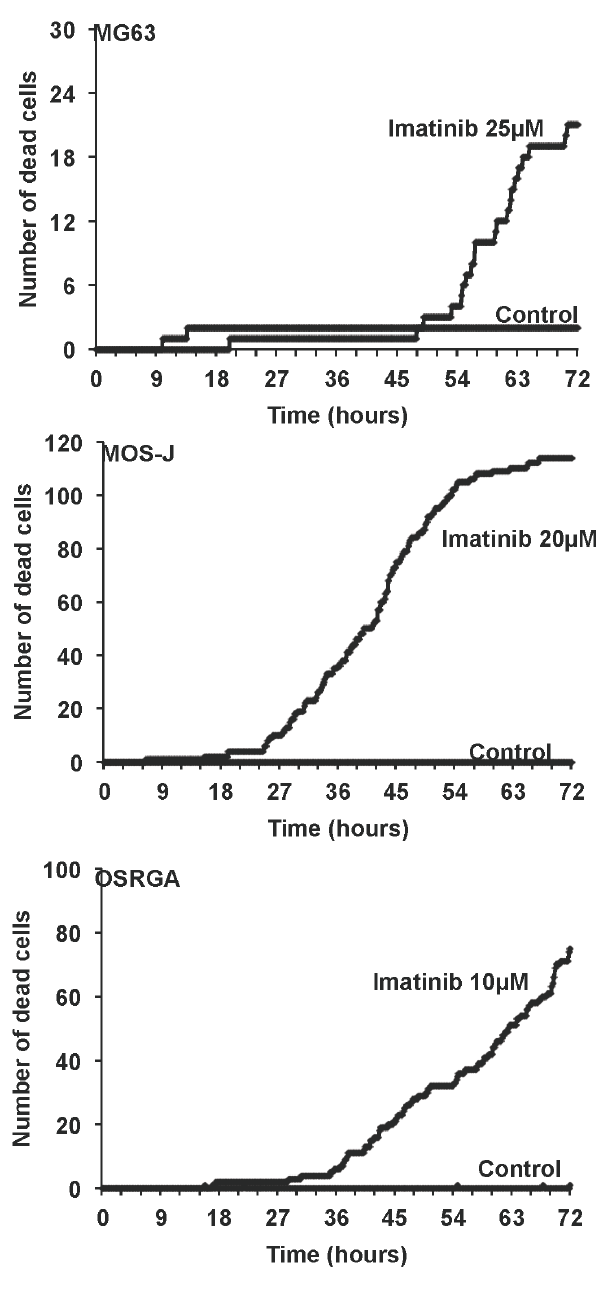
Figure 4. Imatinib mesylate increases osteosarcoma cell death. A kinetic of human (MG63), mouse (MOS-J) and rat (OSRGA) osteosarcoma cell death was analyzed by time-lapse microscopy in the presence or the absence of 25 m M, 20 m M or 10 m M imatinib mesylate respectively. The number of cell death was manually scored every 10 minutes until 72